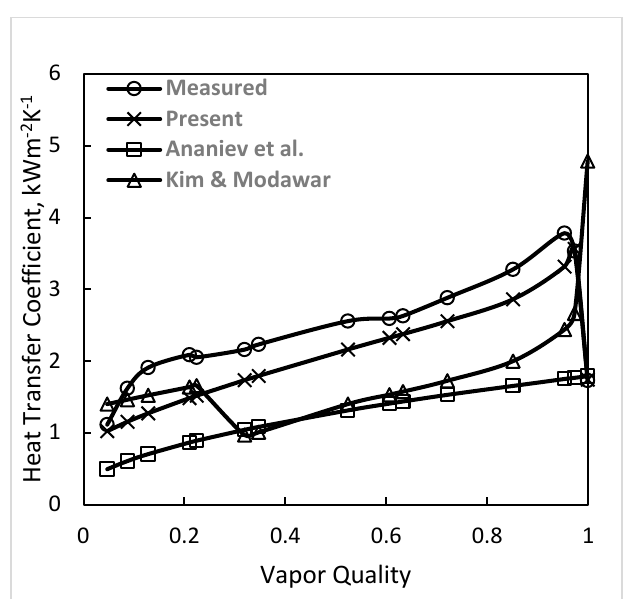
Figure 3. Data of Agarwal and Hrnjak [17] for R-134a compared to some correlations. T SAT = 30 °C, G = 100 kg·m − 2 s − 1 .